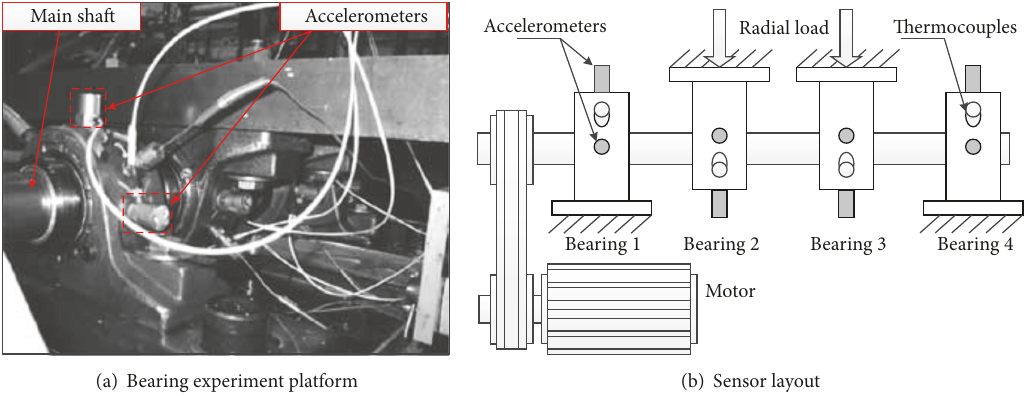
Figure 3: Illustration of the bearing experiment platform.